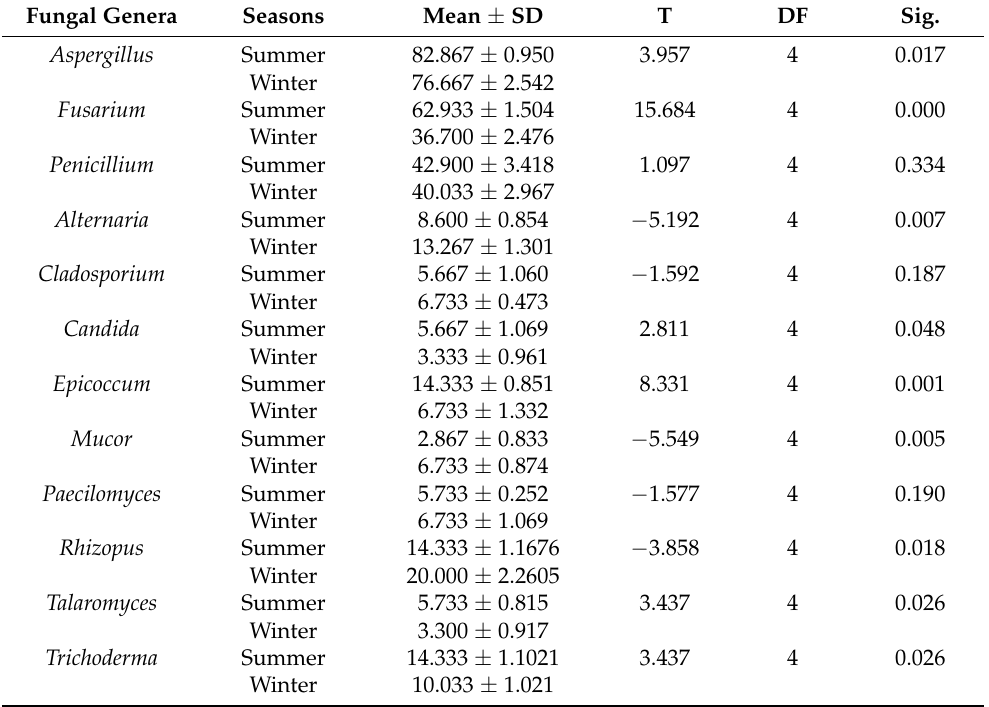
Table 2. Independent sample t -test on variation with isolation frequencies of fungal genera recovered from dairy cattle feeds during summer and winter seasons in Free State and Limpopo provinces, SA.